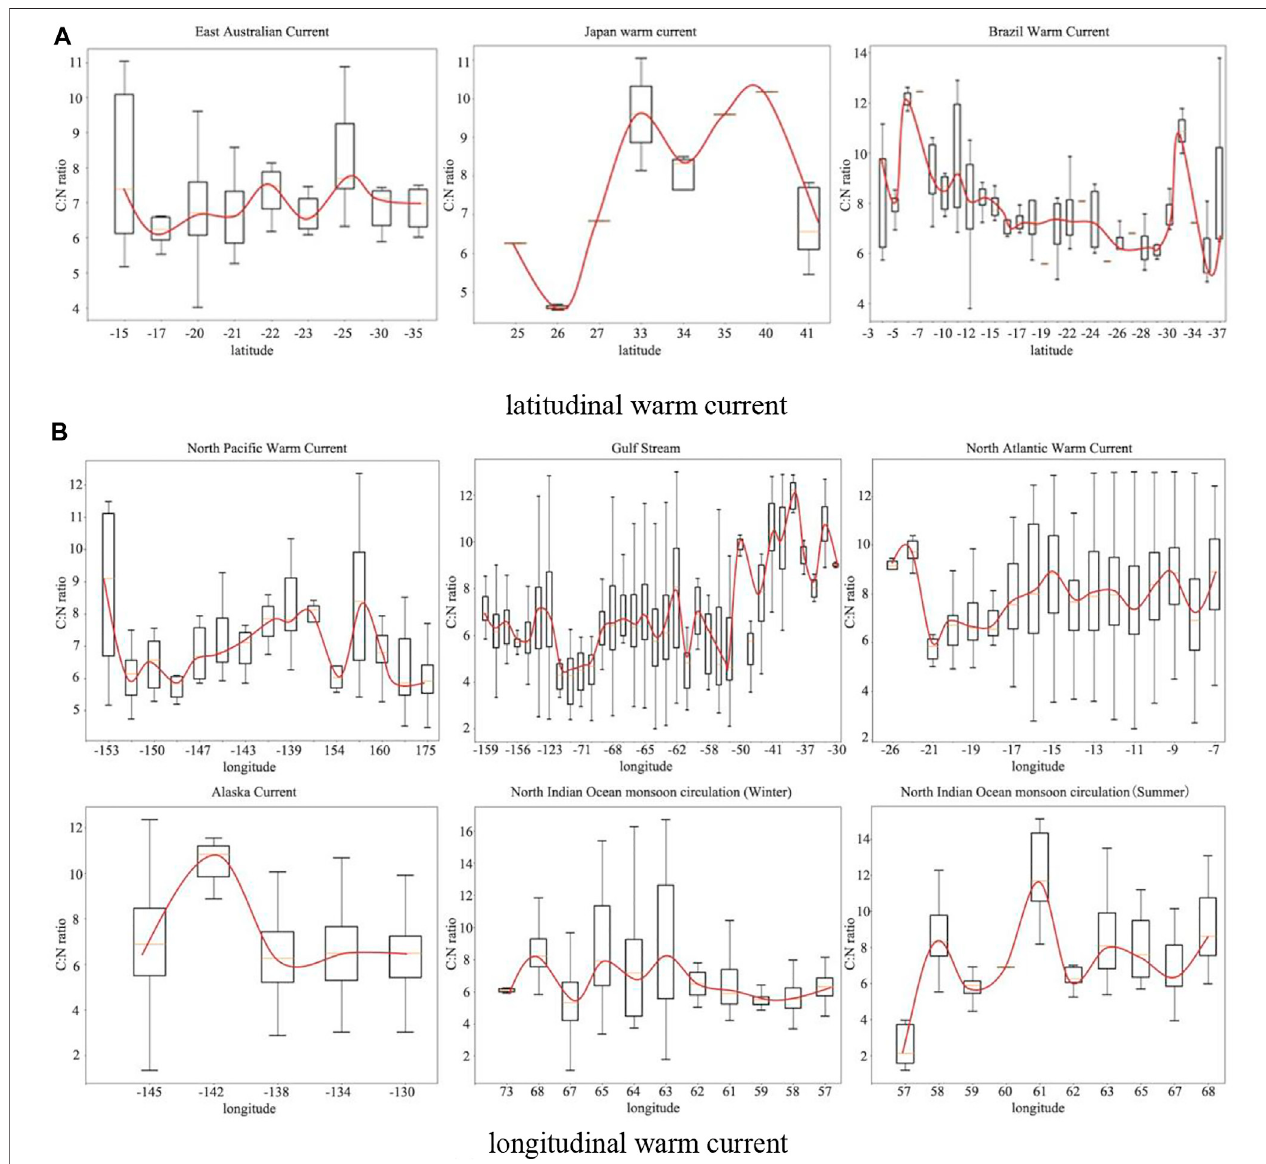
FIGURE 4 | POC-to-PON ratio variation along warm currents. (A) Latitudinal warm current. (B) Longitudinal warm current.